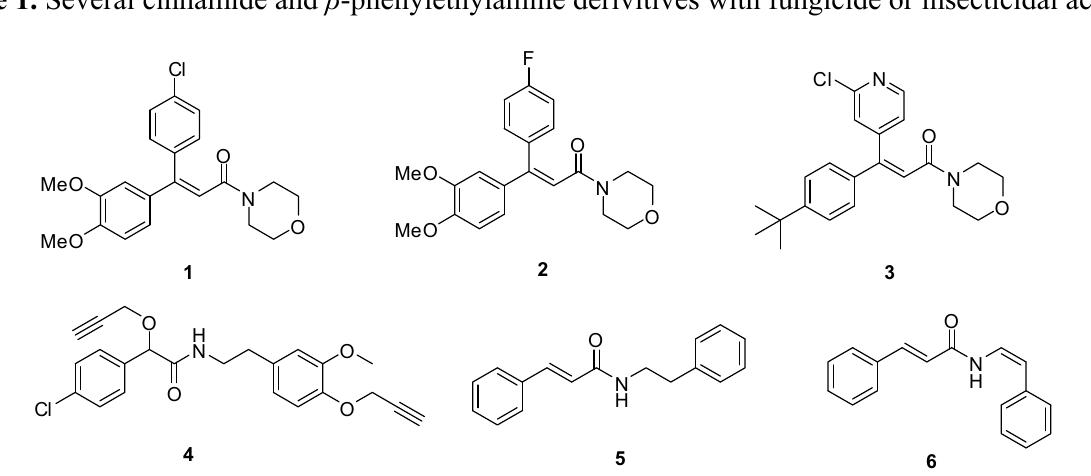
Figure 1. Several cinnamide and β -phenylethylamine derivitives with fungicide or insecticidal